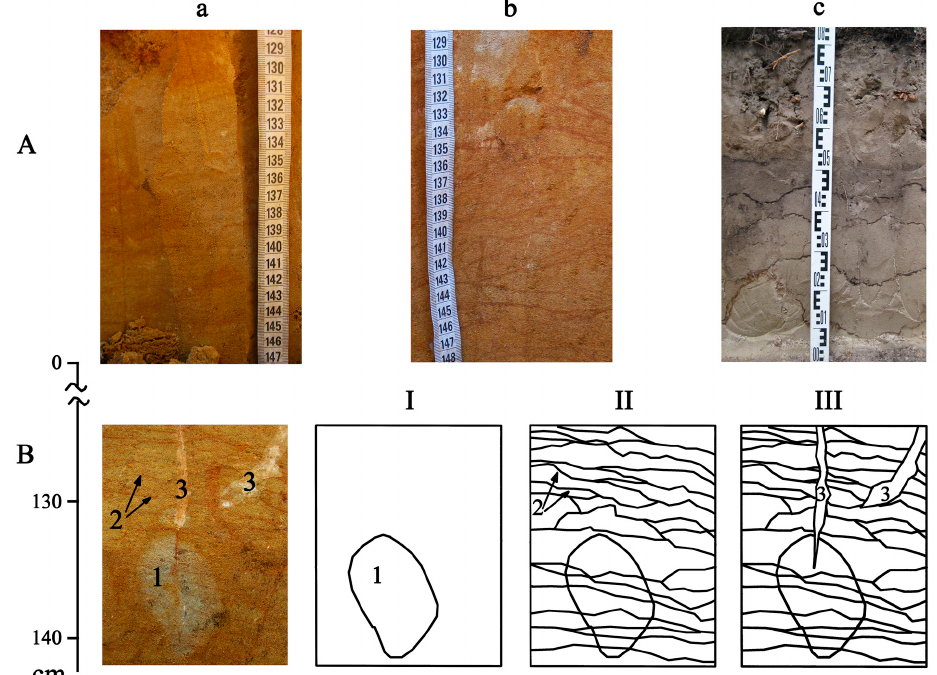
Figure 4. ( A ) lamellas in the lower part of the modern ( a ) and buried ( b ) Chernozems of the Yamskaya steppe, and (for comparison) in the profile of the Gray Forest Soil (Phaeozem) on sandy loam, forest-steppe of the Central Russian Upland ( c ); ( B ) fragment of a lower part of the buried Chernozem with heterogeneous signs: 1—traces of tree roots, 2—lamellas, 3—shrinkage cracks, filled with carbonates. I, II, III–stages of these features formation.